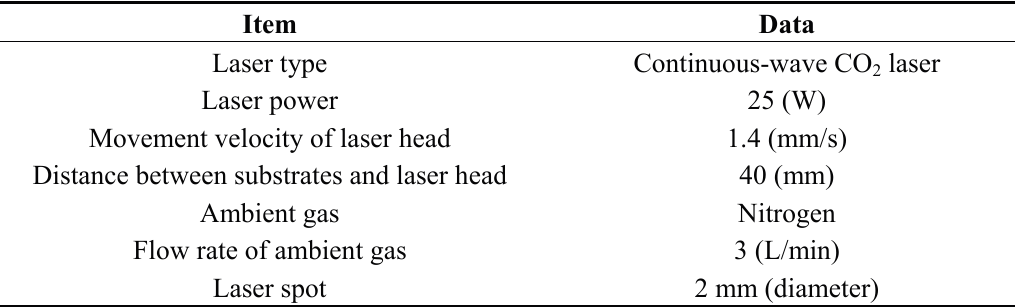
Table 3. Process parameters for ZnO film treated by laser